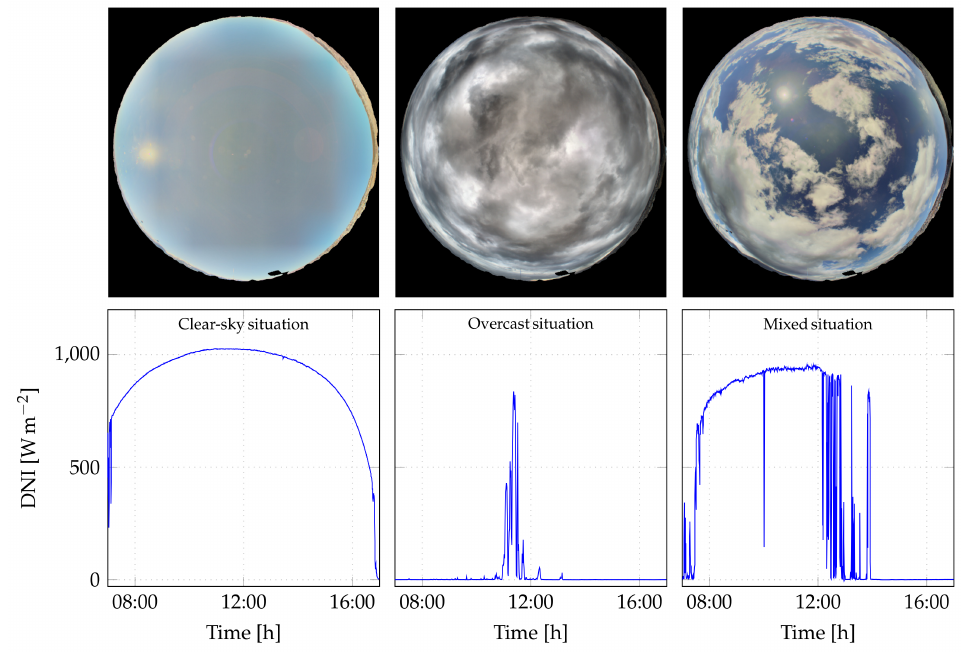
Figure 12. High-dynamic-range (HDR) sky images and associated sky situations: clear sky, overcast and mixed. Days with mixed situations can be partially clear sky or partially